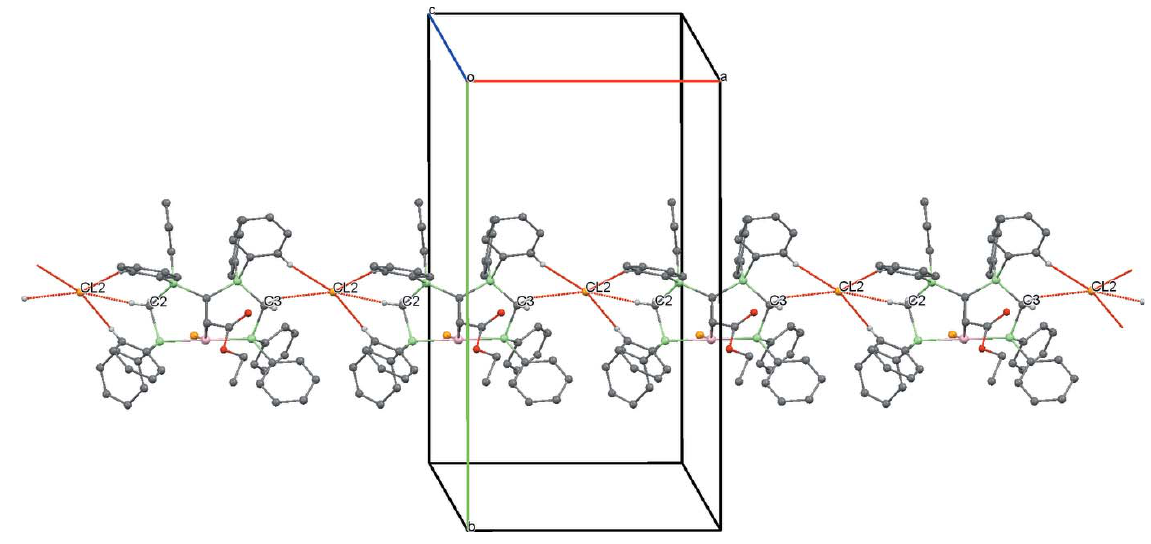
Figure 6 Aview along the c axis of the crystal packing of compound 4 . Only the H atoms involved in the most significant intermolecular interactions (Table 2) are displayed and the intramolecular interaction is omitted.